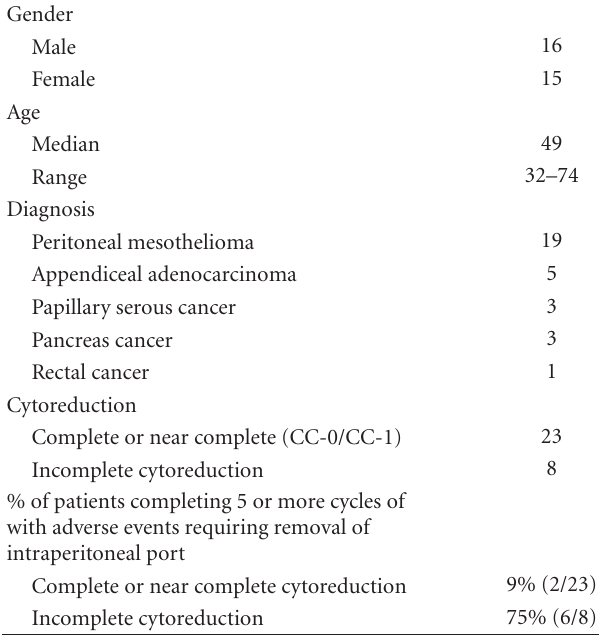
Table 1: Clinical data on 31 consecutive patients given chemother- apy through a permanent intraperitoneal port placed prior to the closure of the